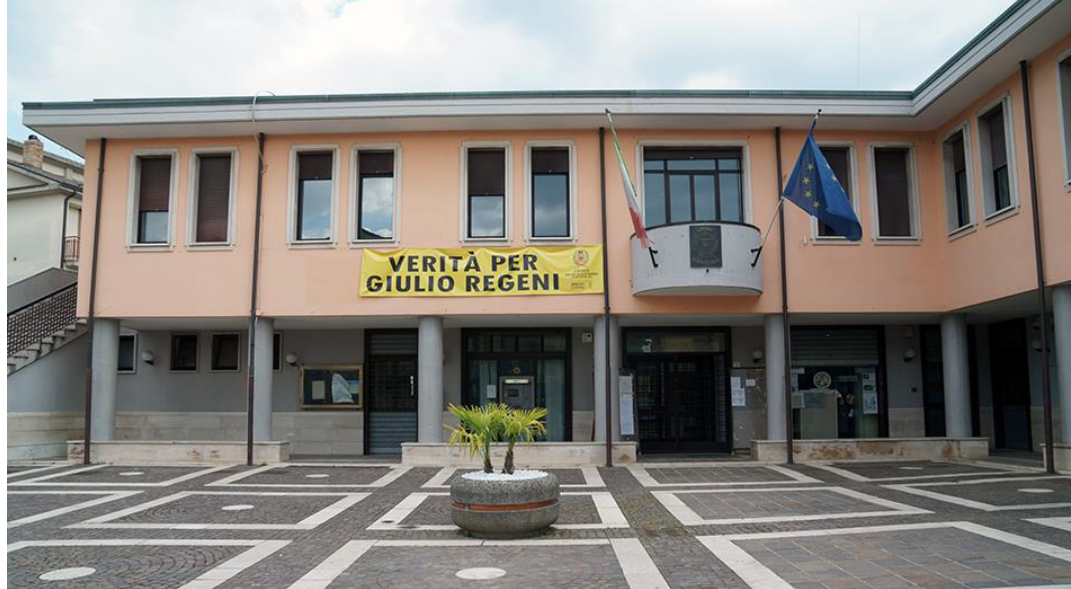
Figure 61. San Michele di Serino: the new municipal building (photos by [35,36]).